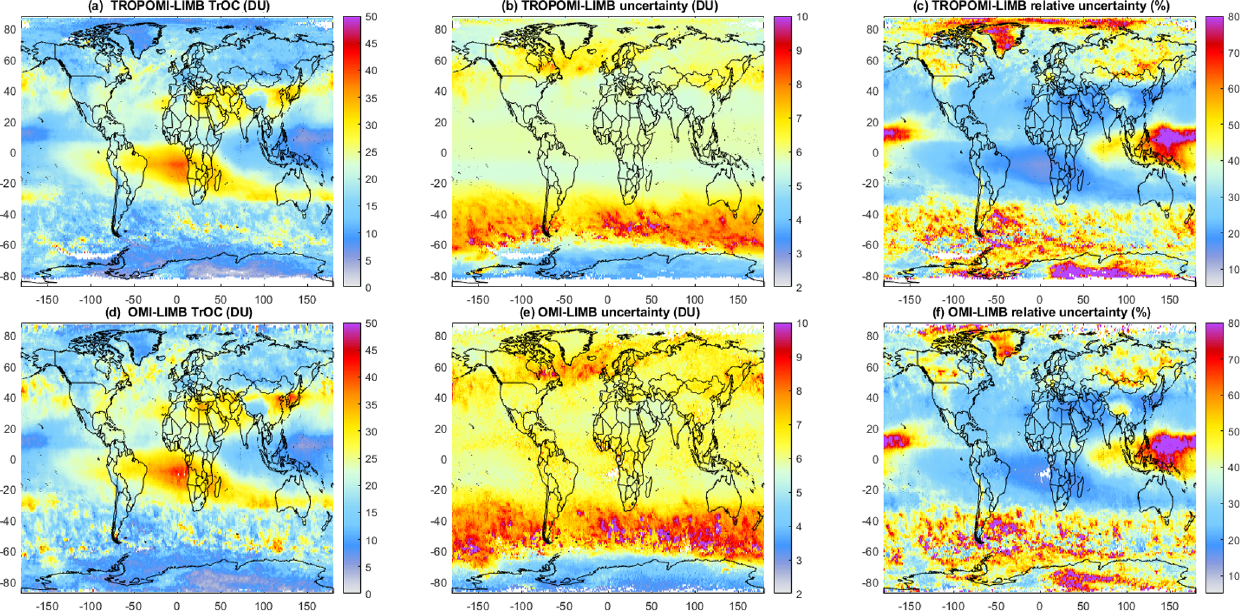
Figure 11. SUNLIT tropospheric ozone distributions (DU, color) for September 2018 from TROPOMI (a) and OMI (d) . The stratospheric ozone column is estimated from 3km below the tropopause. The corresponding estimated uncertainties are shown in absolute values (DU) in panels (b) and (e) and in relative values (%) in panels (c) and (f)